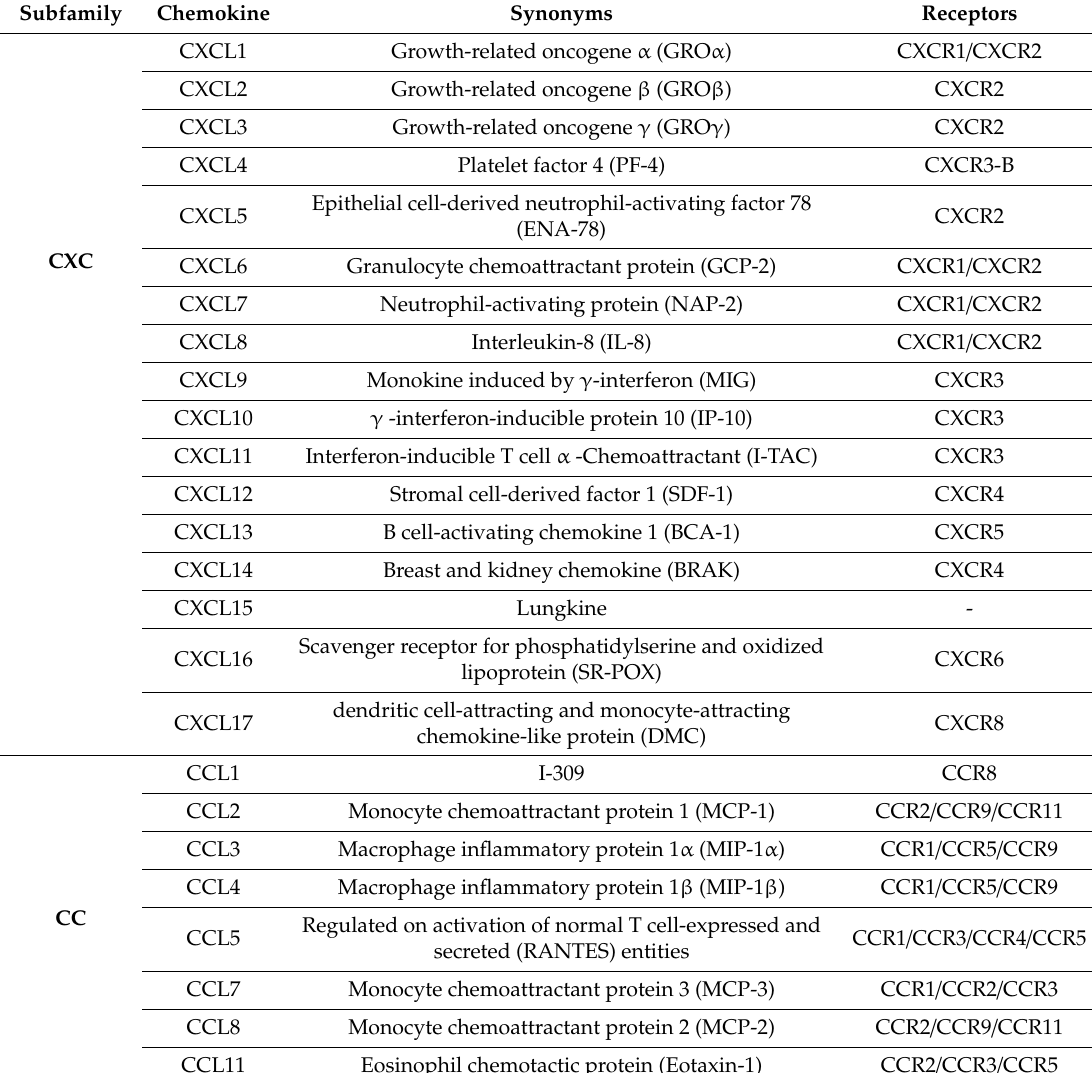
Table 1. Chemokines and their known receptors. Chemokine receptors, which belong to the superfamily of GPCRs, can bind to multiple chemokines, and certain chemokines can similarly bind to more than one receptor. Adapted from Zlotnik and Yoshie 2012